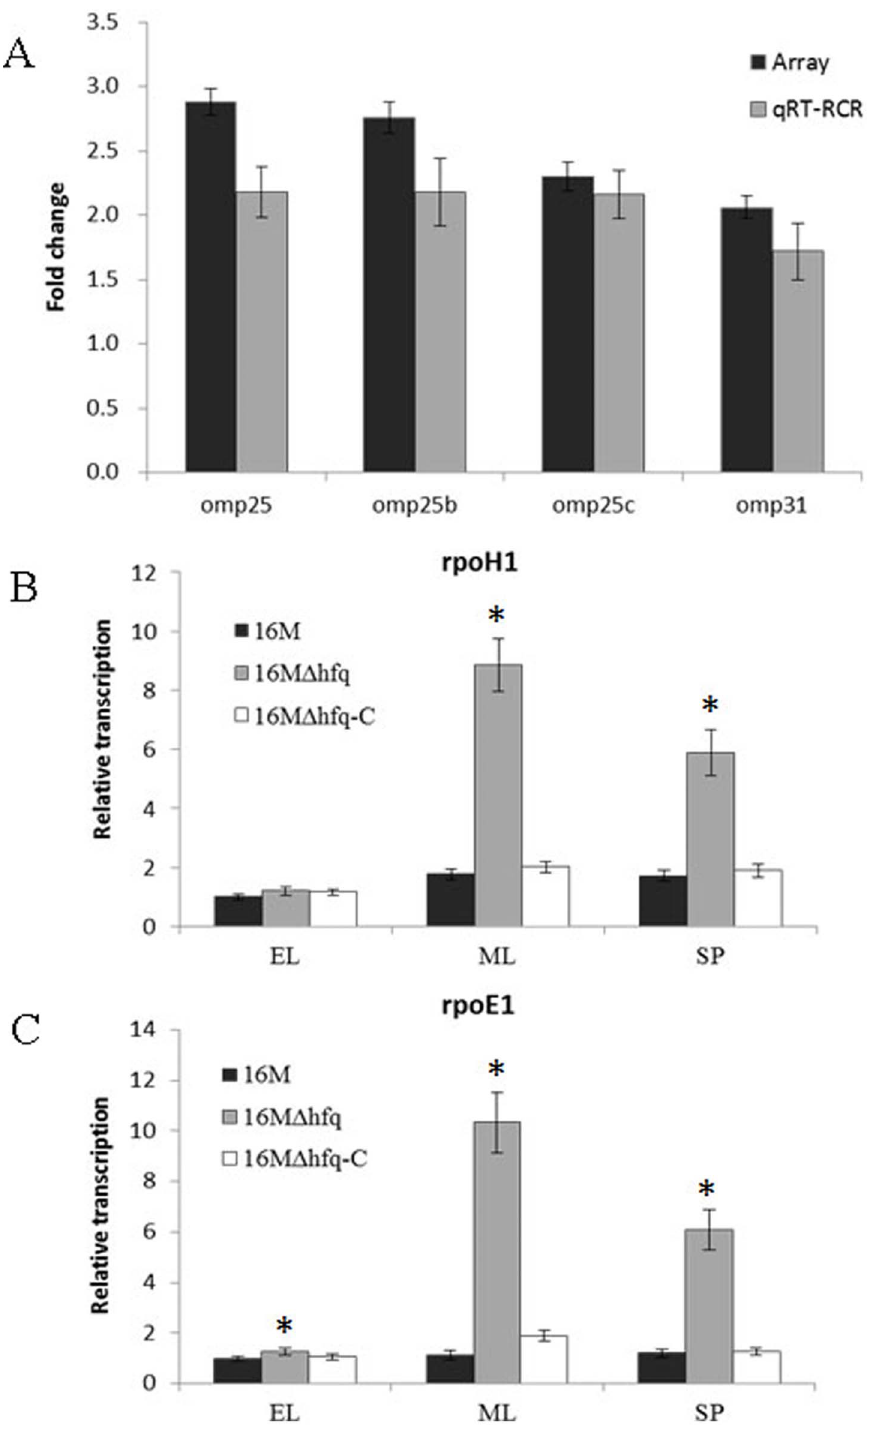
Figure 5. Hfq upregulated the expression of Omp25/Omp31 and the Sigma factors. A. Fold changes in the transcript abundances of omp25 , omp25b , omp25c , and omp31 genes were detected by microarray and qRT-PCR in 16 M D hfq, relative to 16 M. B, C. Transcript abundances of rpoH1 (B) and rpoE1 (C) were detected in the 16 M, 16 M D hfq, and 16 M D hfq-C during early logarithmic (EL), mid-logarithmic (ML), and stationary phases (SP). Significant differences between the transcription abundances of rpoH1 and rpoE1 in the mutant and parent strain are indicated as follows: *, P , 0.001.